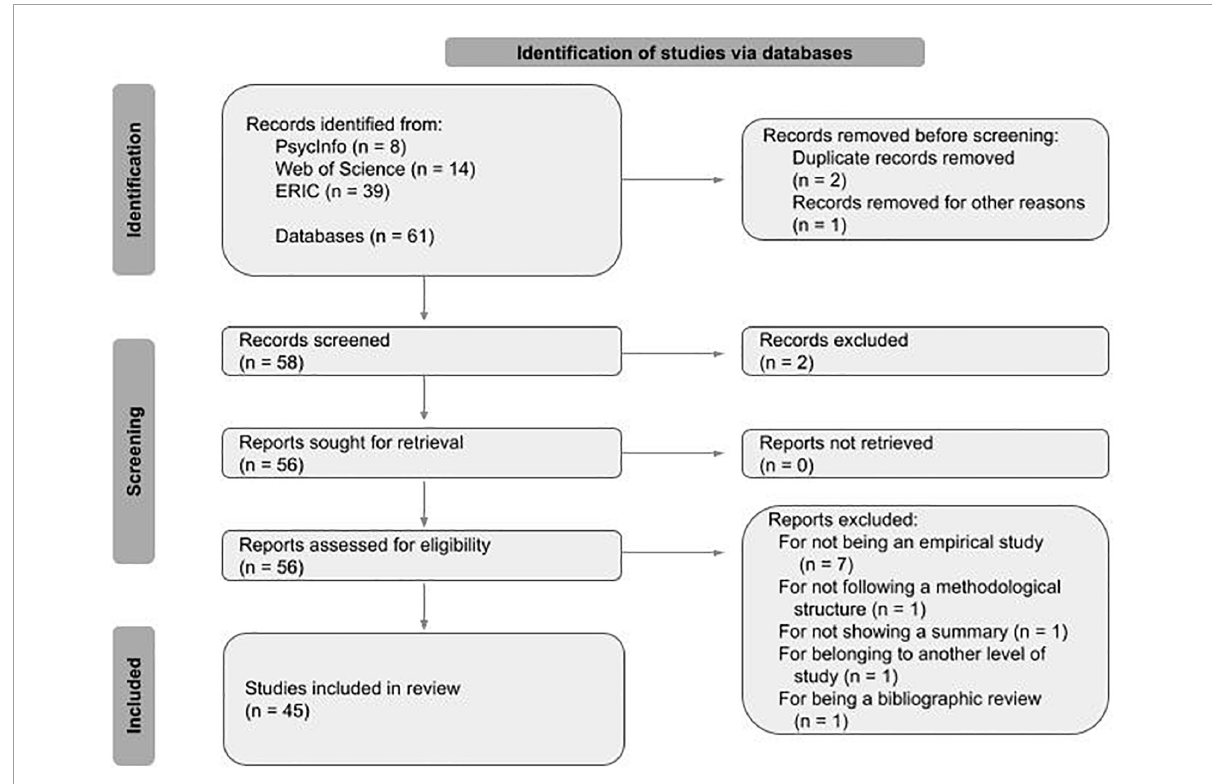
FIGURE1 Flow diagram (PRISMA 2020) with selection